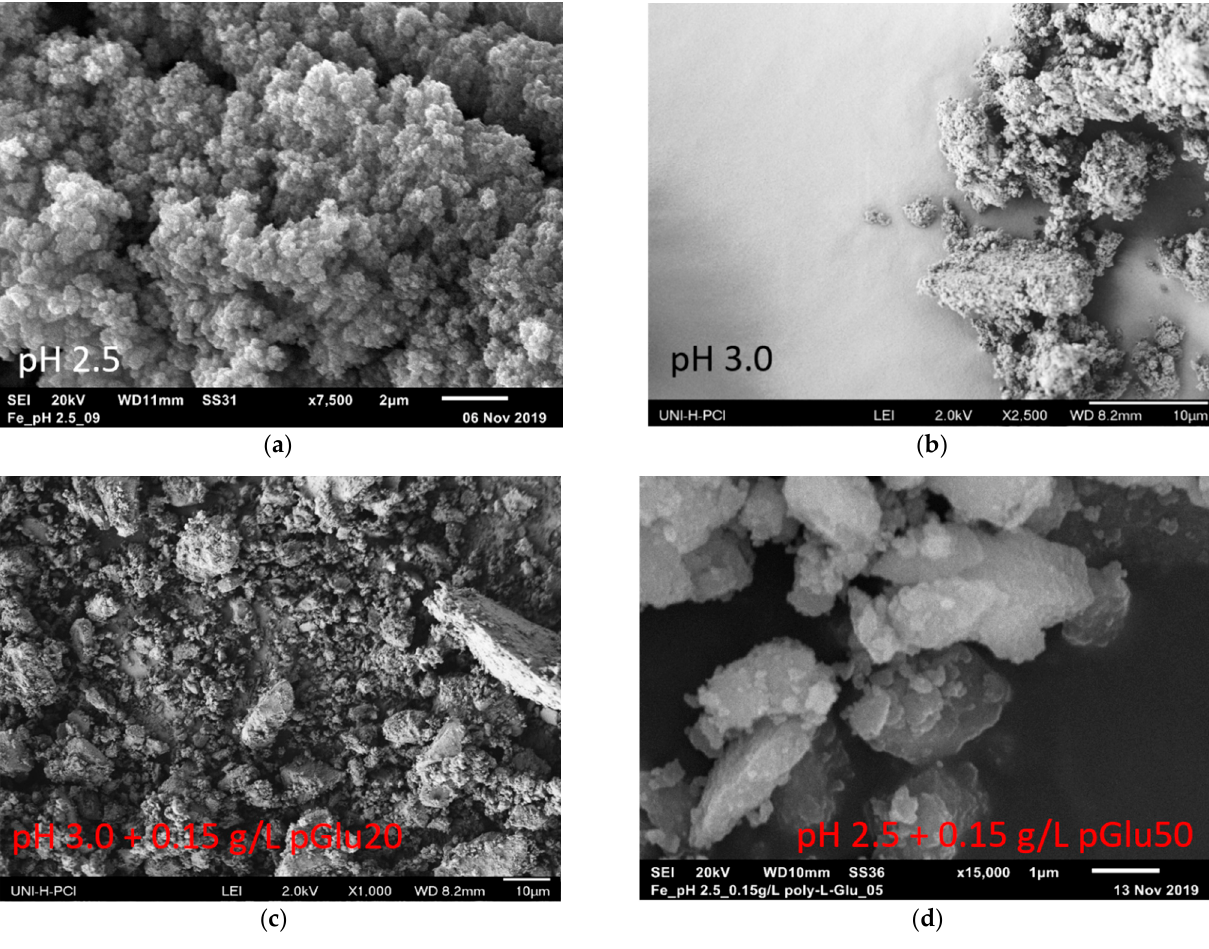
Figure 5. SEM micrographs of powders drawn after titrations: ( a ) pH 2.5 and ( b ) pH 3.0 without an additive; ( c ) pH 3.0 + 0.15 g/L pGlu20, and ( d ) pH 2.5 + 0.15 g/L pGlu50.